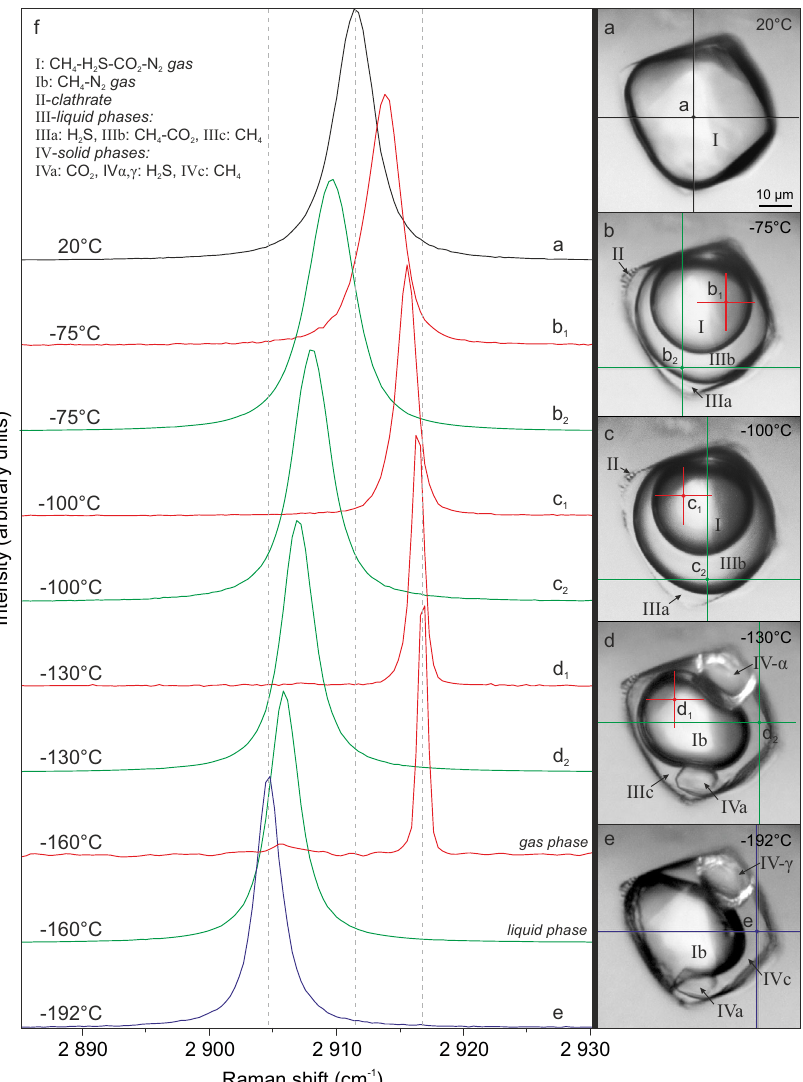
Fig. 5 Raman spectra of symmetric stretching ( ν 1 ) region of CH 4 gas in a natural CH 4 – H 2 S – CO 2 – N 2 – H 2 O fl uid inclusion gas mixture (no. P1- fi 1A) at low temperatures. a – e Microphotographs of measured individual phases in analyzed gas-rich inclusion. f Sequence of Raman spectra showing that with decreasing temperature Raman peak positions of the exsolved liquid and gas methane shift to lower and higher wavenumbers, respectively. This is a result of relative density increase/decrease during differential partitioning between co-existing phases. The FWHM of the Raman peaks also decrease with decreasing temperatures. Symbols: I: CH 4 – H 2 S – CO 2 – N 2 gas, Ib: CH 4 – N 2 gas, II-clathrate, III-liquid phases: IIIa: H 2 S, IIIb: CH 4 – CO 2 , IIIc: CH 4 ,